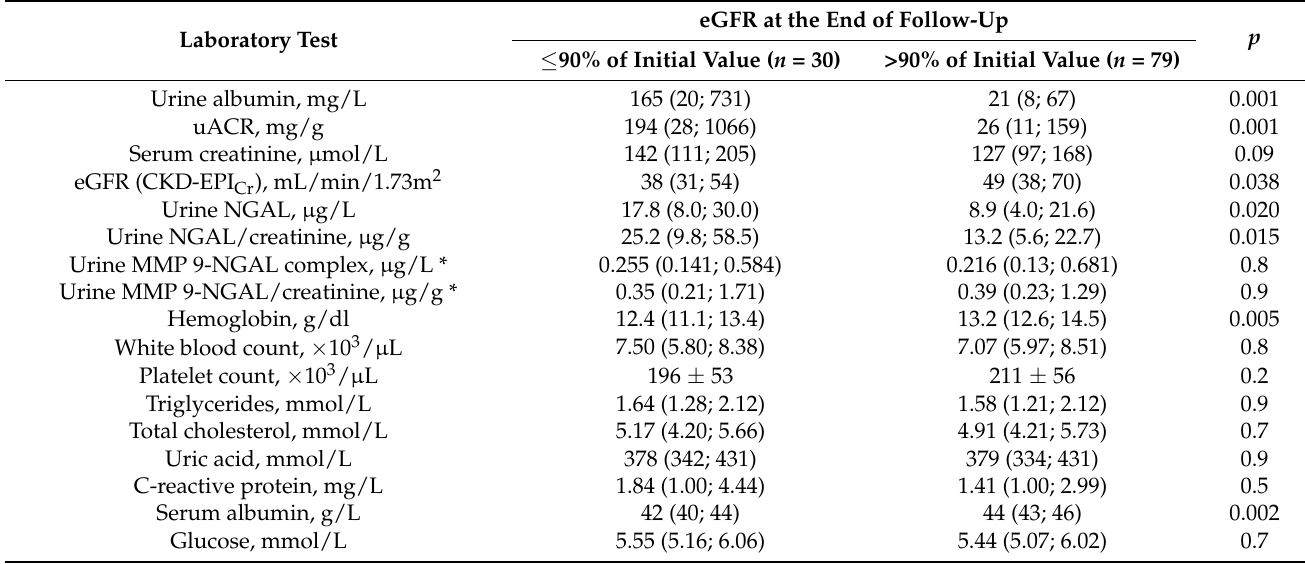
Table 2. Baseline results of laboratory tests according to eGFR changes during follow-up. Data are shown as mean ± SD or median (Q1;